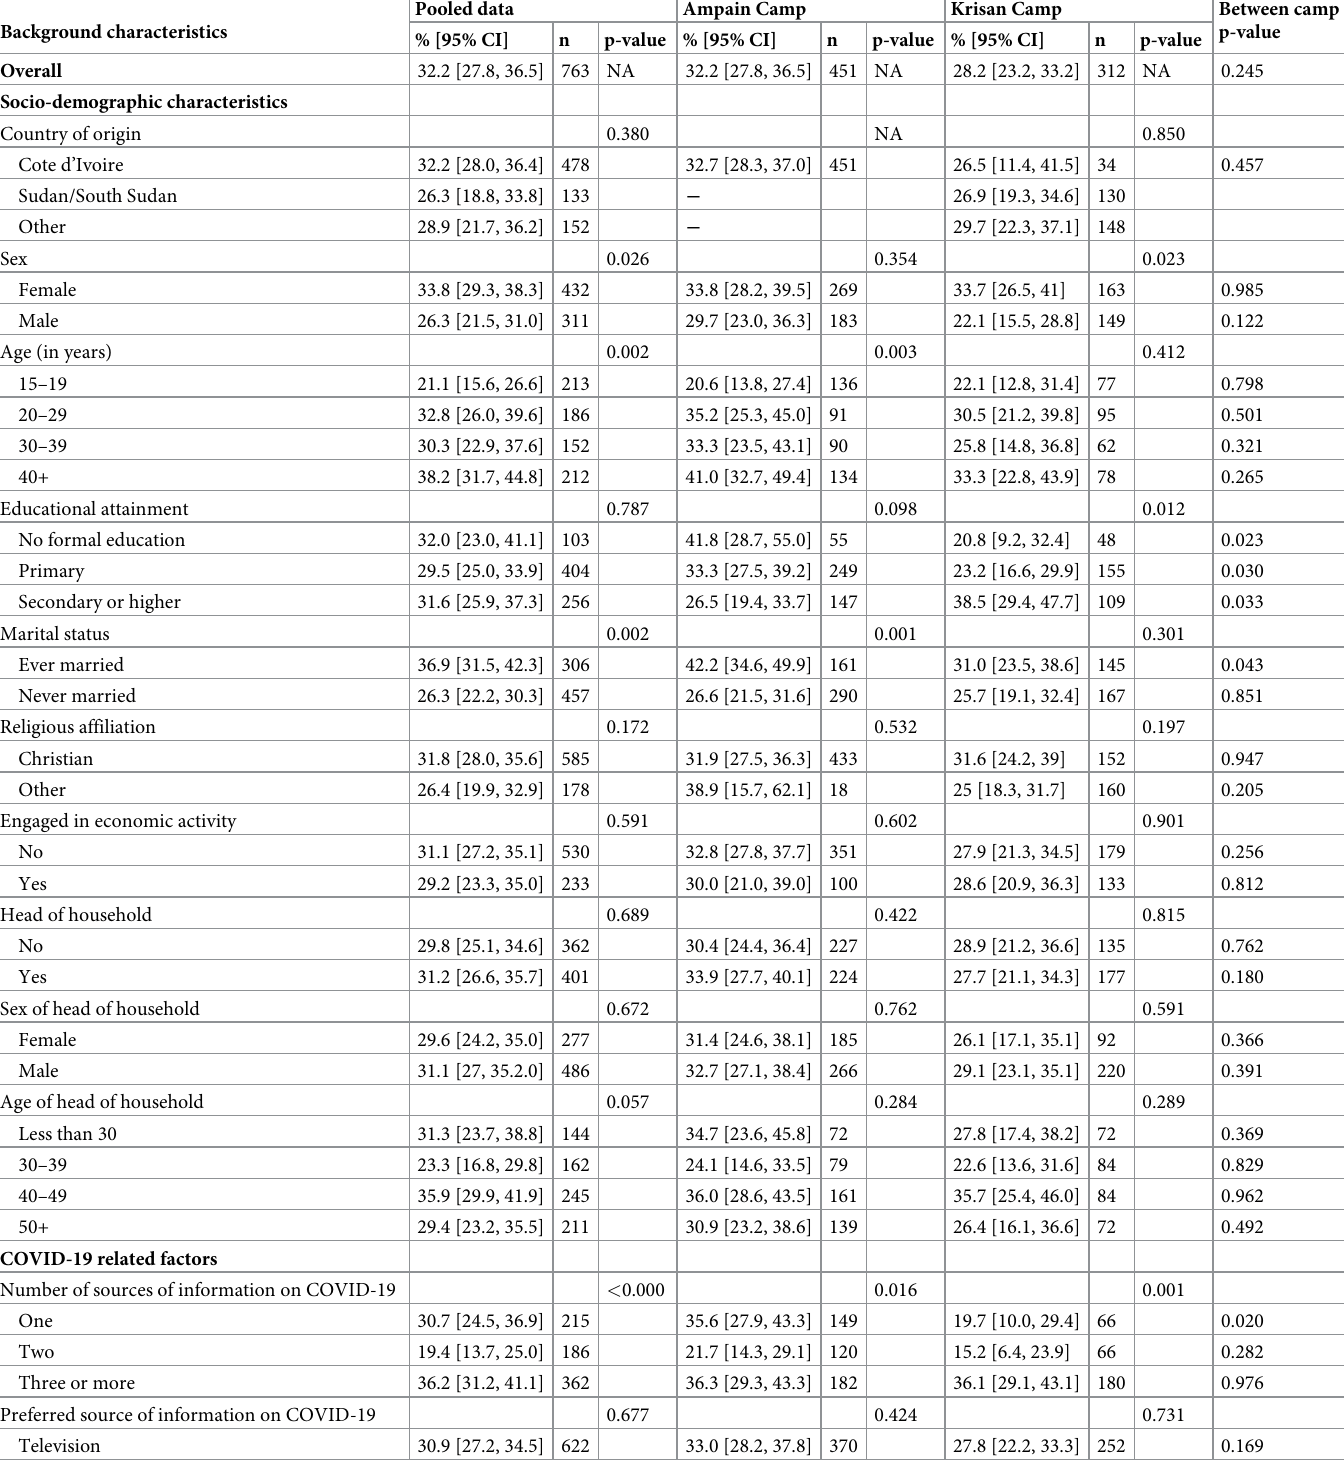
Table 4. Percentage distribution of respondents who had severe psychological impact of the COVID-19 pandemic by socio-demographic characteristics, COVID- 19 related factors, pre-existing health conditions and challenges within the camps. Background